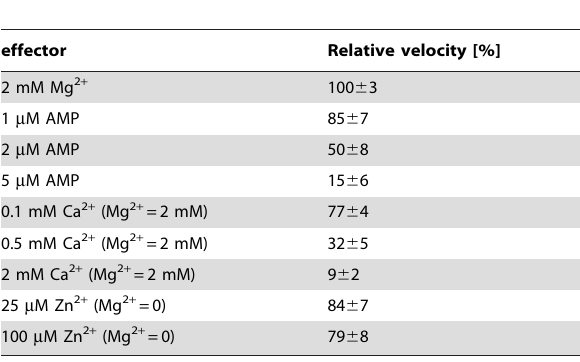
Table 2. The influence of FBPase effectors on the reverse reaction of FBPase Tyr 57 Trp